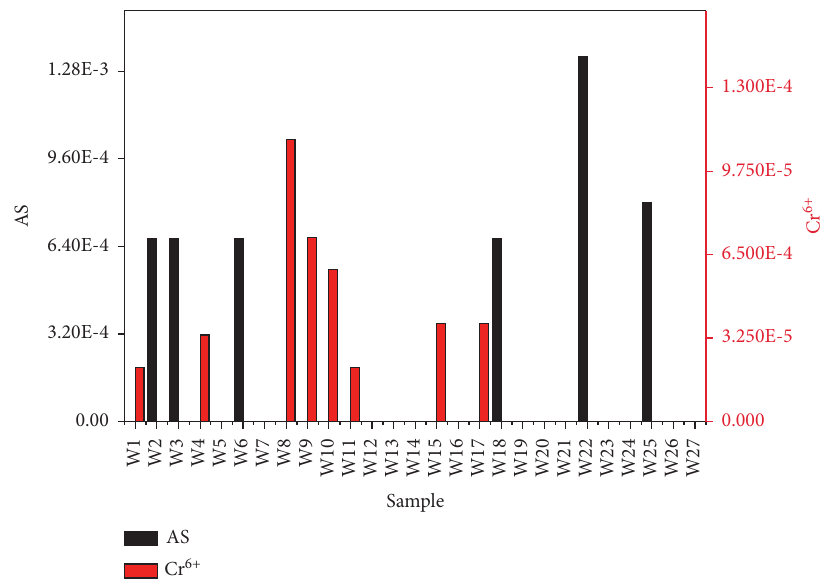
Figure 10: Carcinogenic risk of the groundwater samples for